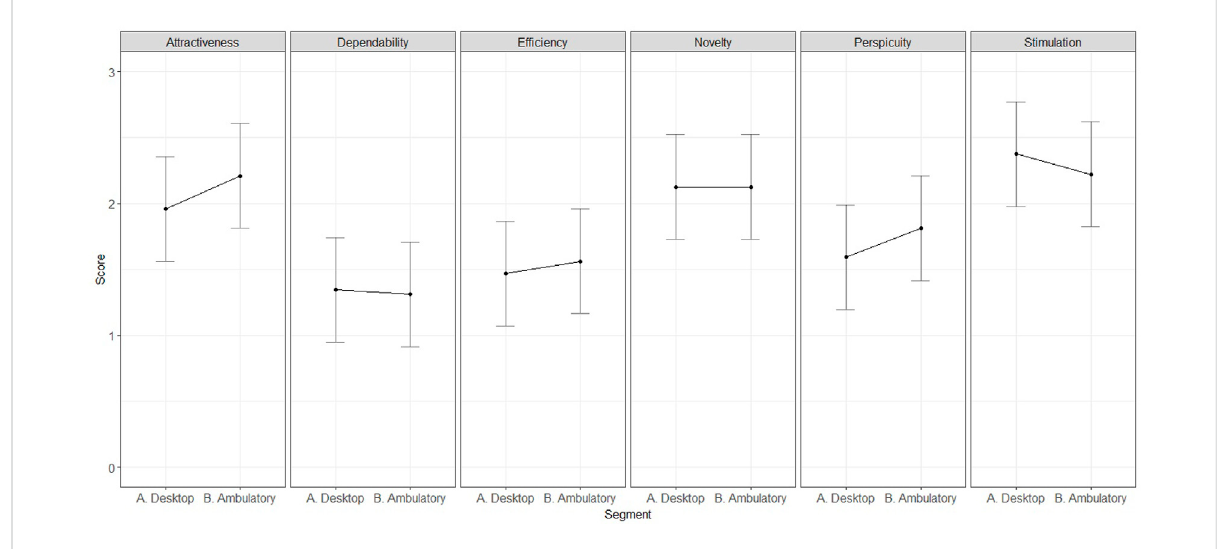
FIGURE 11 Performanceexperiment — compiledUEQresultsofzero-centered7-pointscalewithordinateaxistruncatedtopositiveinterval[0,3].Errorbars correspond to a con fi dence interval of 95%.